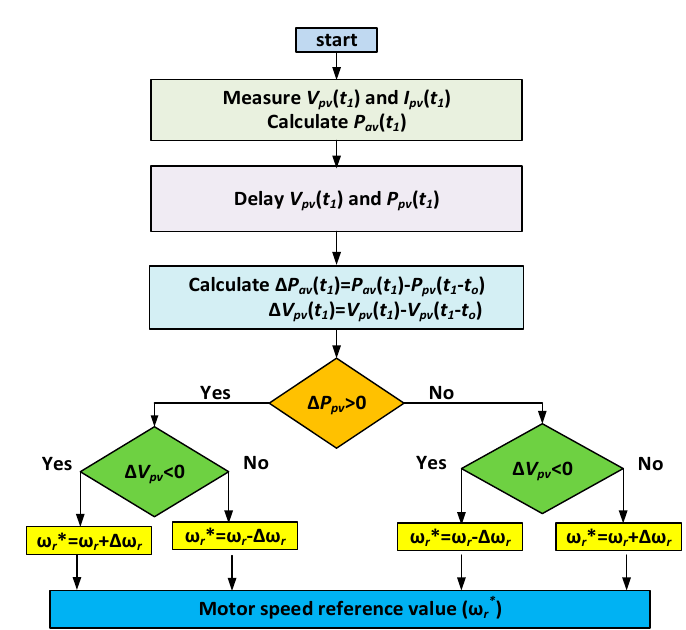
Figure 9. Main tracking steps of using the perturbation and observation (P&O) technique.